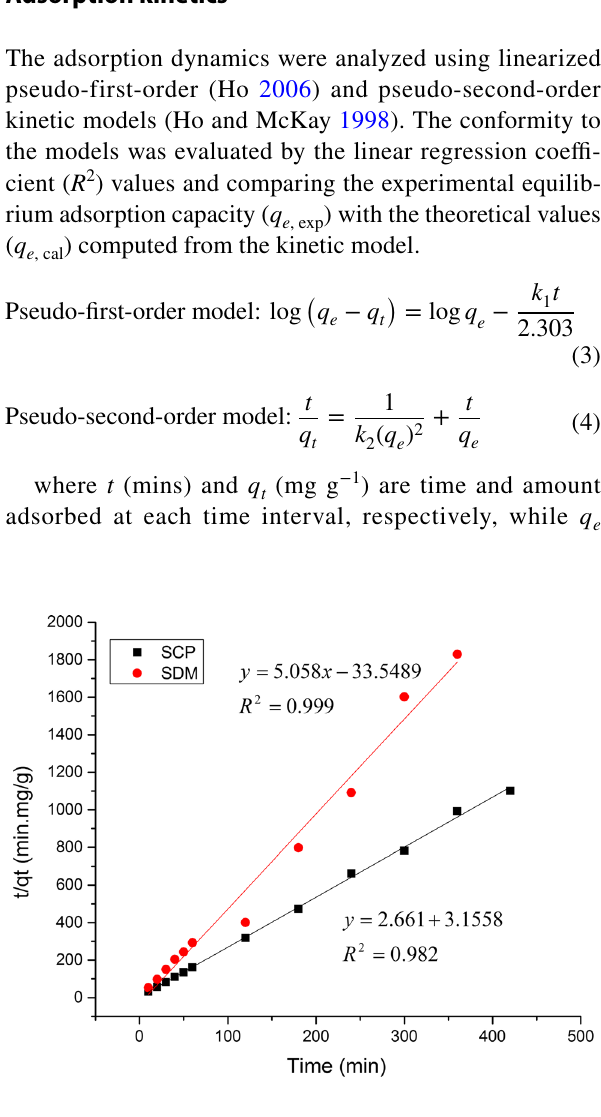
Fig. 5 Intra-particle diffusion graph for adsorption of SCP and SDM onto Fe-MC ( m = 0.1 g/50 mL, C i = 1 ppm, pH =